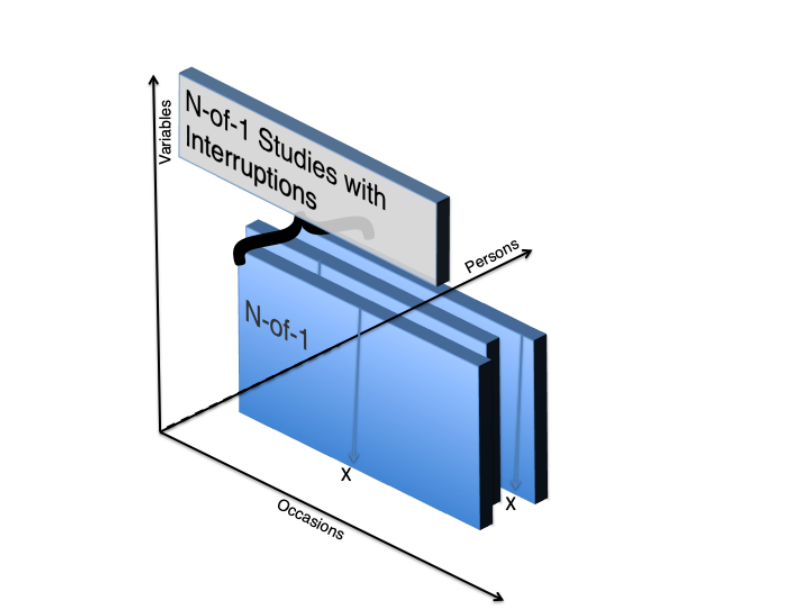
Figure 2: Experiments with interrruptions (e.g., self-experimental